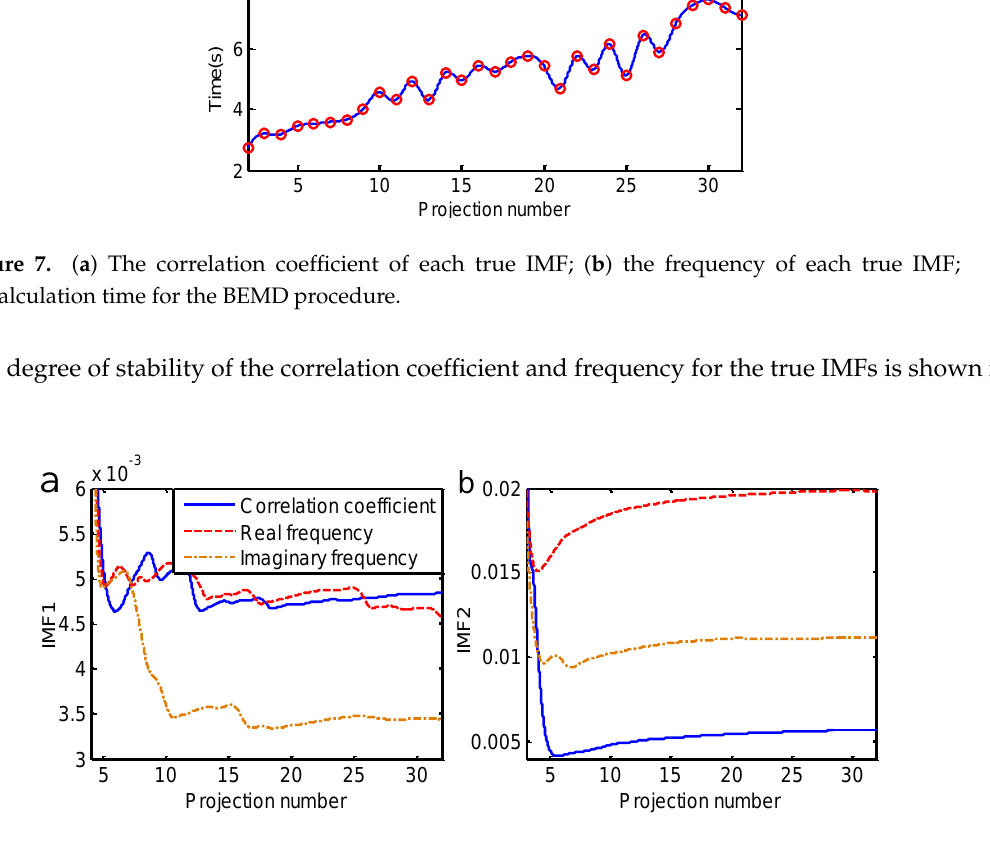
Figure 8. ( a ) The stability degree of correlation coefficient and frequency from IMF1; ( b ) the stability degree of correlation coefficient and frequency from IMF2. Blue solid lines represent the correlation coefficient, red dashed lines represent the frequency components of the real part of IMF1, yellow dotted lines represent the frequency components of the imaginary part of IMF2.